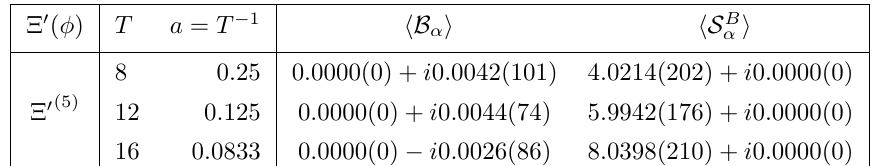
for the odd-degree α